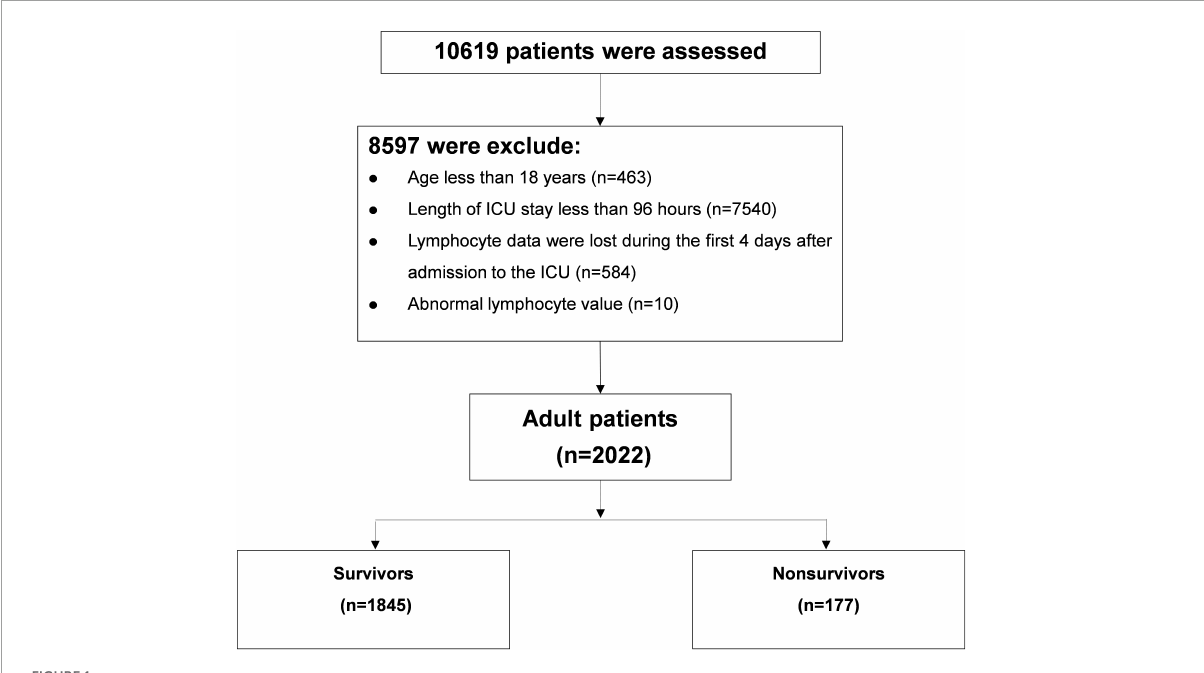
FIGURE1 Flow chart of critically ill patients.